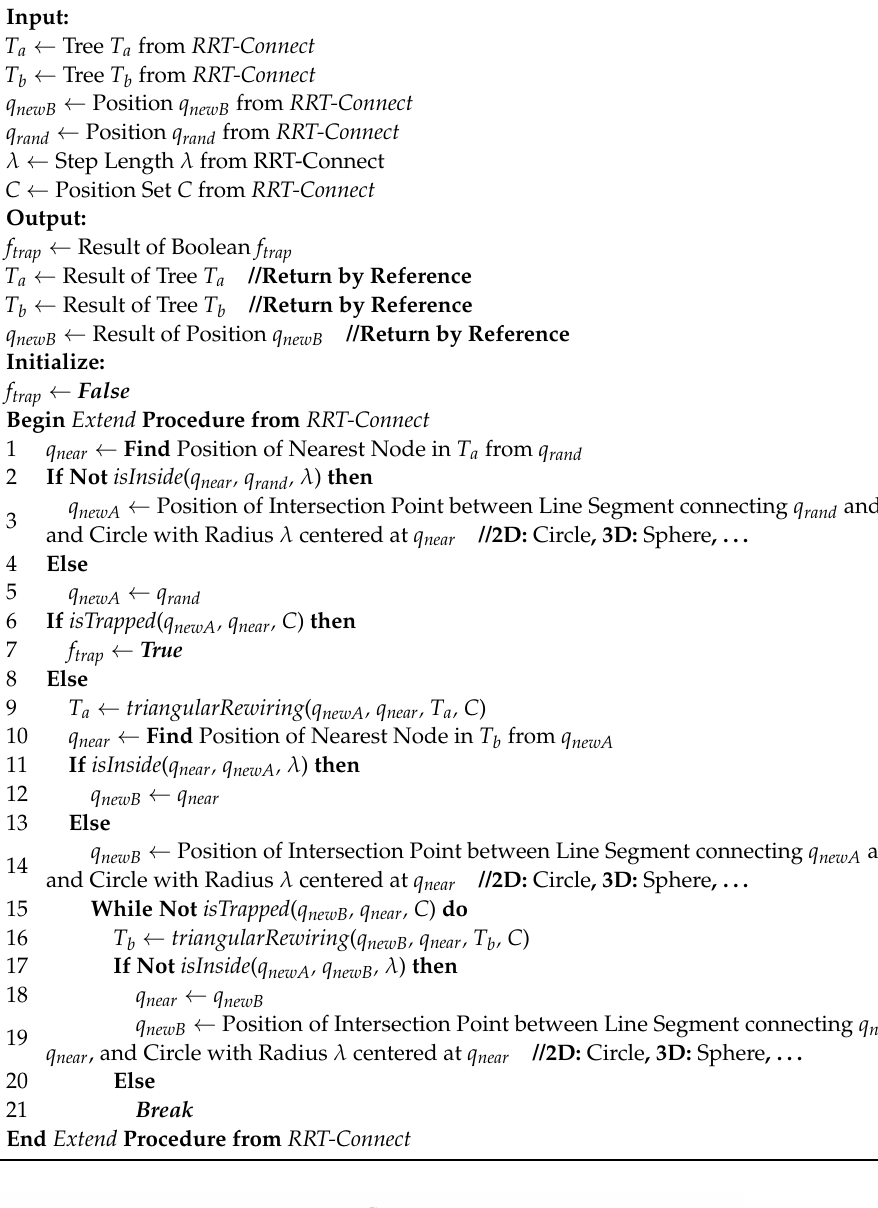
Algorithm 5 Pseudocode of the Proposed ‘Extend’ Method for the RRT-Connect Algorithm